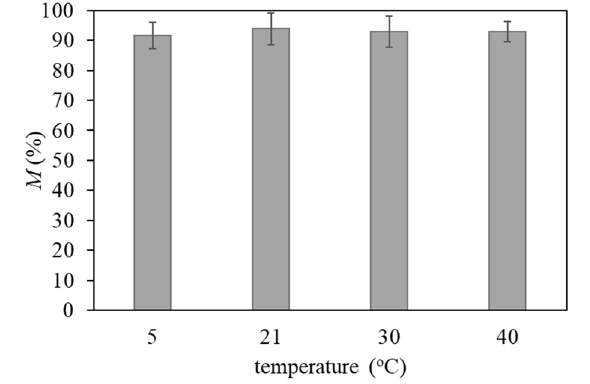
Figure 5. Effect of temperature in the Pb 2+ removal efficiency by FucoPol ( C i 10 mg/L, FucoPol Figure5. EffectoftemperatureinthePb 2 + removalefficiencybyFucoPol( C i 10mg / L,FucoPolconcentration concentration 5 g/L, pH 4.3, incubation time 24 h). 5 g / L, pH 4.3, incubation time 24